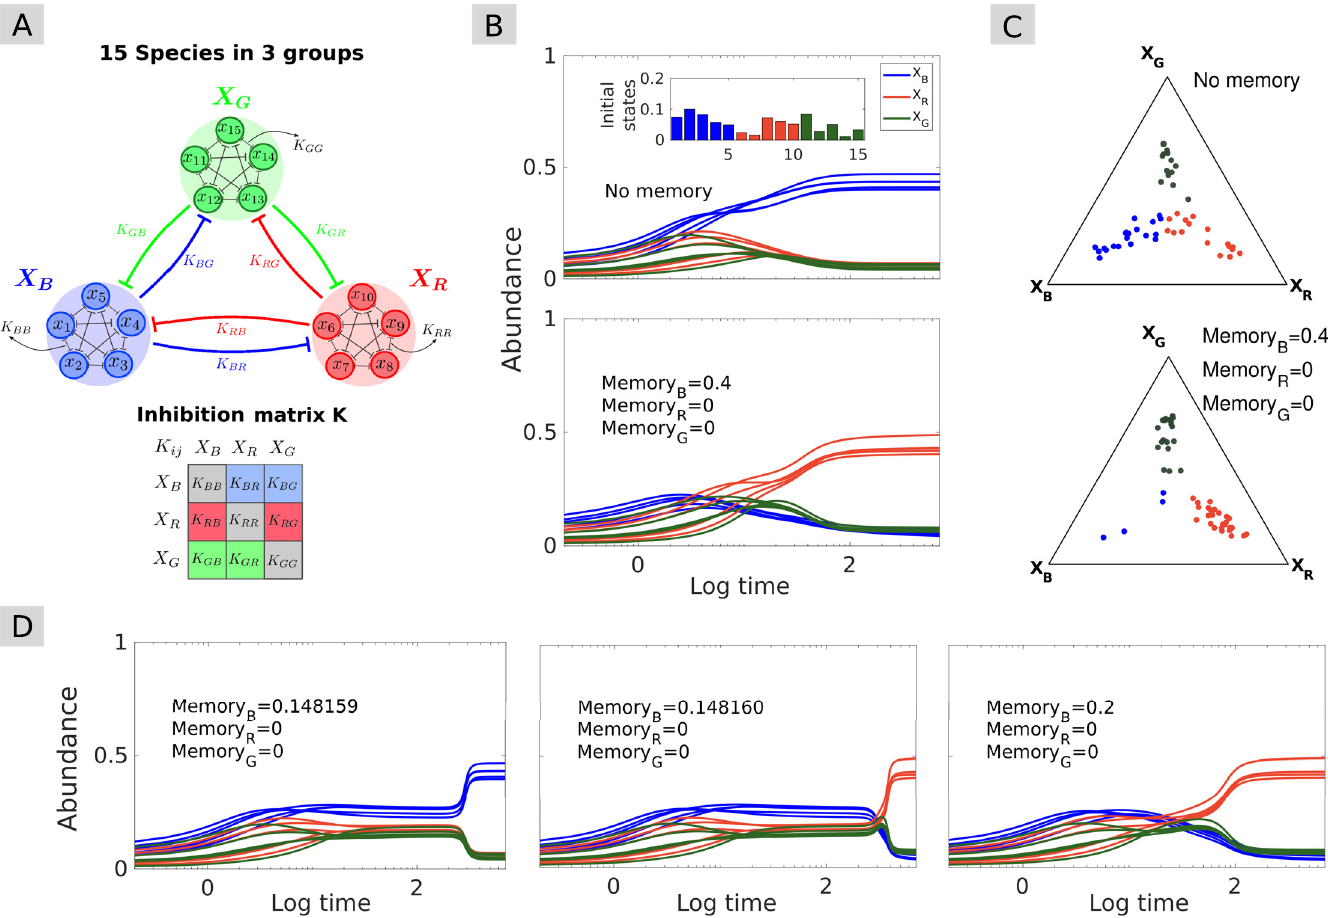
Fig 5. Impact of incommensurate memory on the community stability landscape: Regime shifts without perturbation. (A) A 15-species version of Gonze’s mutual interaction model (see Gonze et al. [25]). The 15 species form three groups, blue, red, and green, and between-group species interactions are stronger than within-group interactions. The resulting system exhibits three stable states, each dominated by a different group. (B) Starting from random initial conditions, the blue group of species dominates the community in the stable state when no memory is present (top). Starting from the same initial conditions, imposing memory on the blue species leads to a temporary rise in abundance, but ultimately another (red) group of species dominates instead (bottom). (C) Ternary plots represent the stable state distributions of 50 simulations with random initial conditions and noise in model parameters. Each dot shows, for one simulation at convergence time, the identity of the dominant group (color) and the average relative abundances of the three groups (position in the triangle; see S1 Appendix for details). In the memoryless system (top), the three groups roughly have the same chance of dominating the stable state, whereas imposing memory effects on the blue set of species (bottom) favors stable states where those species are not dominant. (D) Setting incommensurate memory in the blue species around the threshold separating two stable states (here, 0.14816) leads to an abrupt regime shift after a long period of subtle, gradual inclines, without changing any model parameters or adding noise.